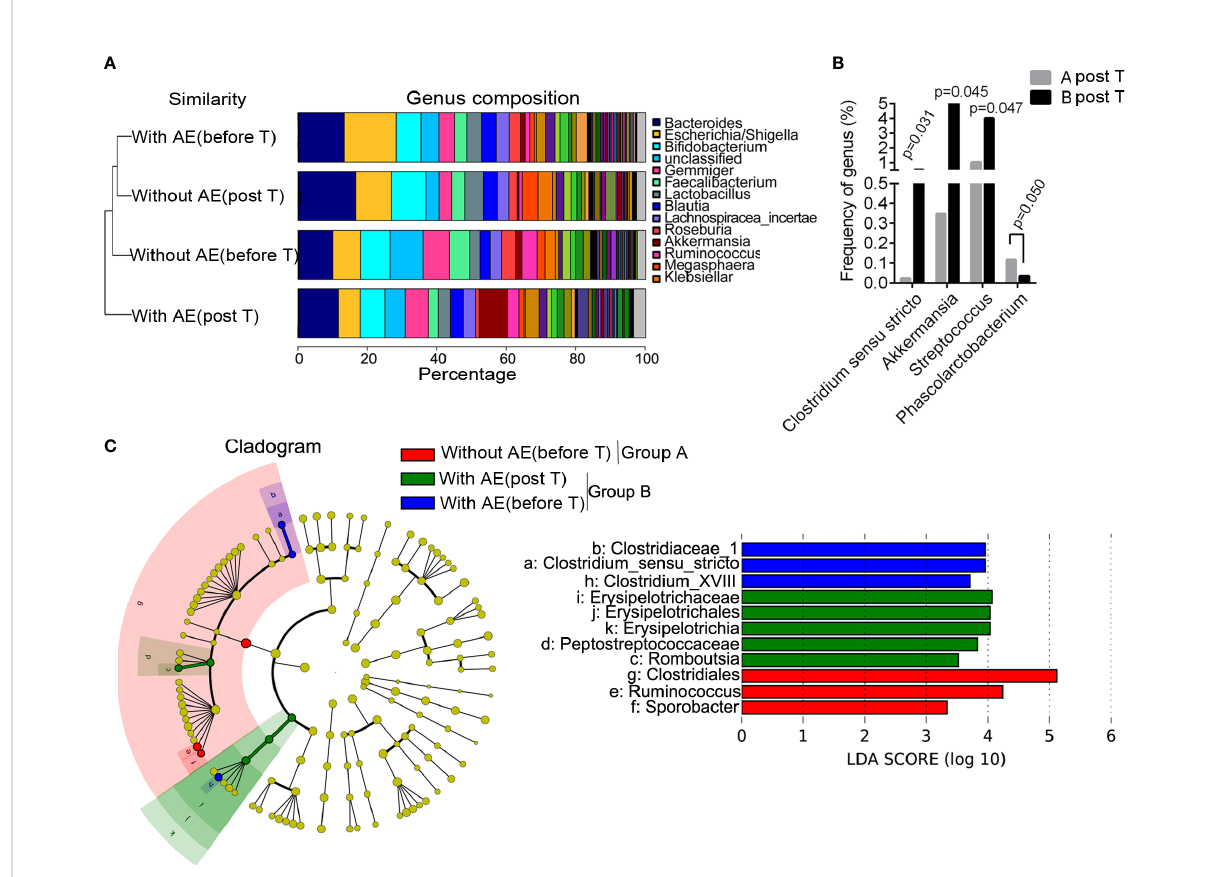
FIGURE 4 Differences in bacterial abundance between patients with and without adverse events. (A) the group similarity of samples at the genus level; (B) the different genera in patients without and with gastrointestinal adverse events after treatment; (C) the LEfSe analysis. AE, adverse events; T,